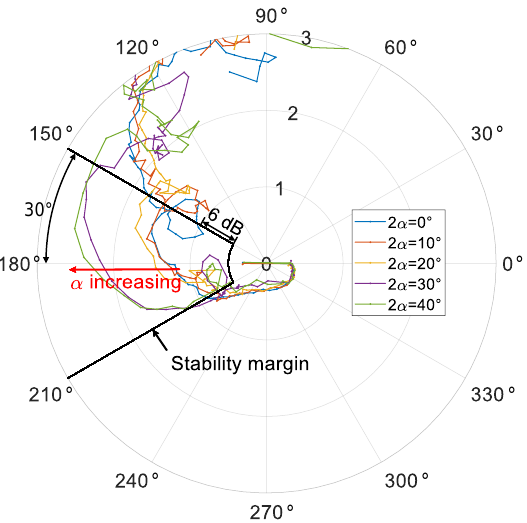
Figure 6. Polar plot of dominant Eigenvalue λ 1 of the return ratio matrix at low frequency range (1–100 Hz) in the dq frame.